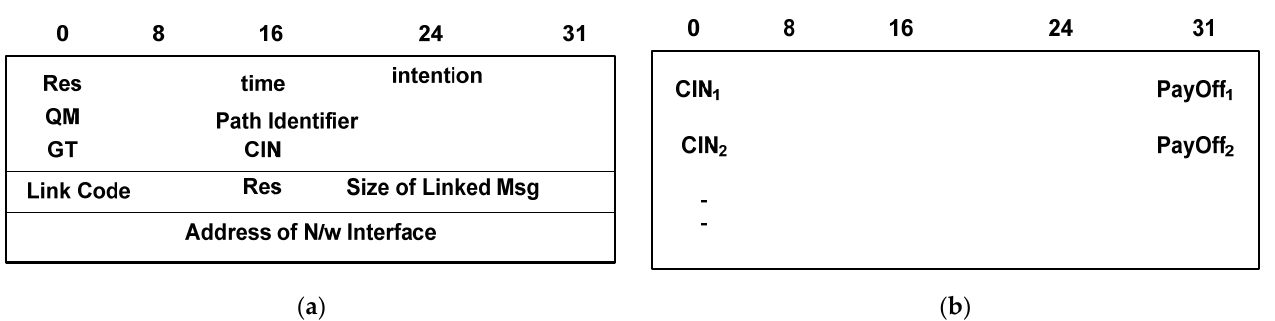
Figure 2. Format of newly formulated control message: ( a ) format for C msg1 ; ( b ) format for C msg2 .